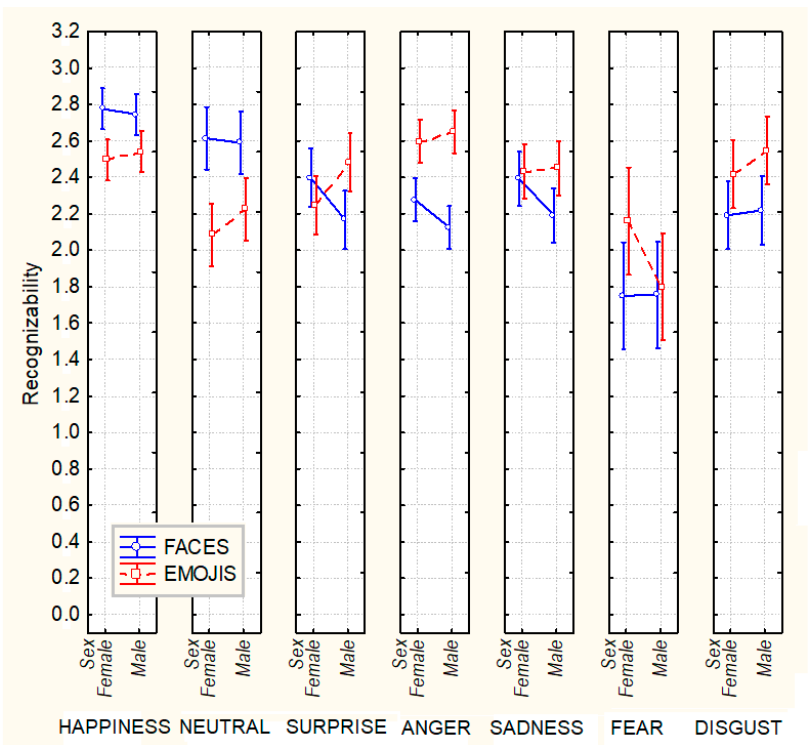
Figure 3. Mean recognizability scores (with standard deviations) measured in male and female participants in response to the seven emotions expressed by human faces and emojis.